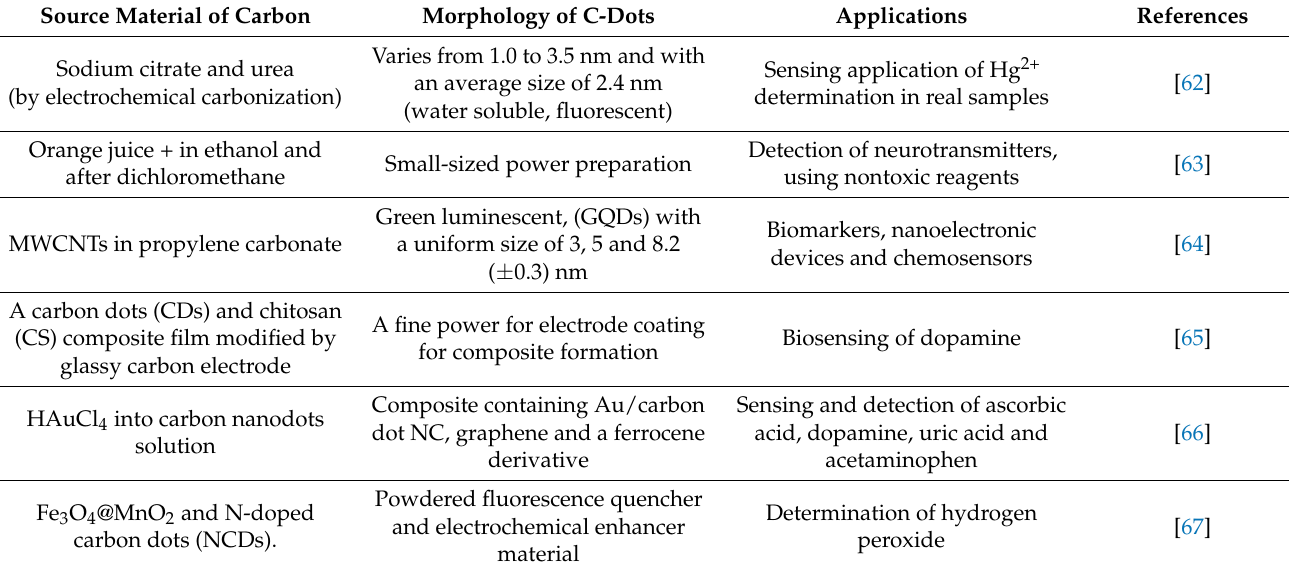
Table 3. Electrochemical-based methods for the synthesis of